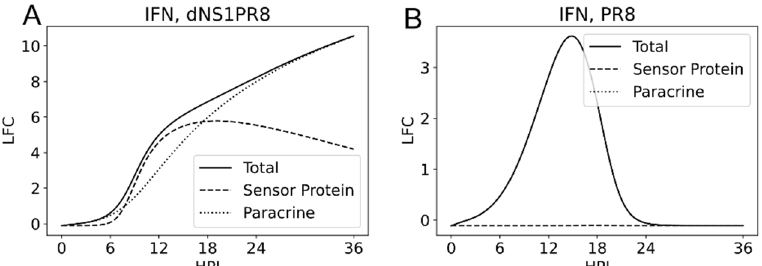
Figure 9. ( A ) Total, Sensor Protein, and Paracrine IFN production simulations in dNS1PR8 influenza. ( B ) Total, Sensor Protein, and Paracrine IFN production simulations in wild-type PR8 influenza. Note that Total and Paracrine IFN production in ( B ) are overlapping. Sensor Protein and Paracrine do not visually sum up to Total, since these plots have a Log-Fold Change space ordinate.